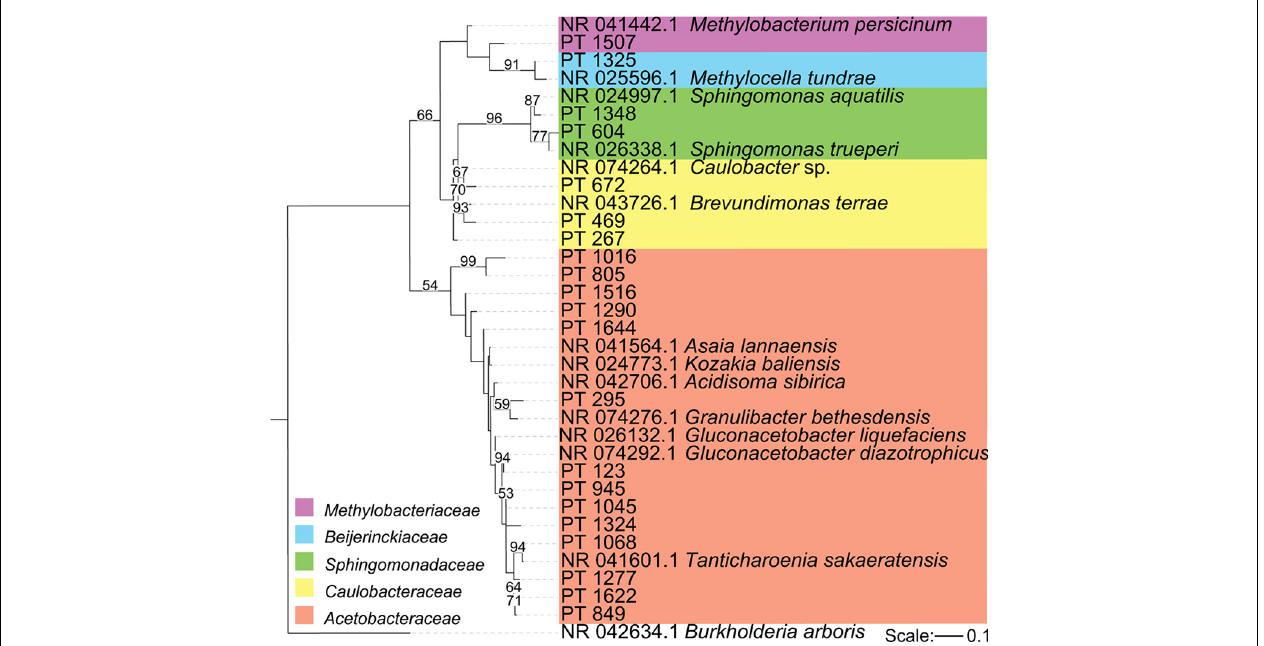
FIGURE 3 | Phylogeny of major Alphaproteobacterial sequences in our samples. Maximum likelihood phylogeny of Alphaproteobacterial sequences that occurred at least 100 times along with the three most closely related sequences from the GenBank 16S rRNA database